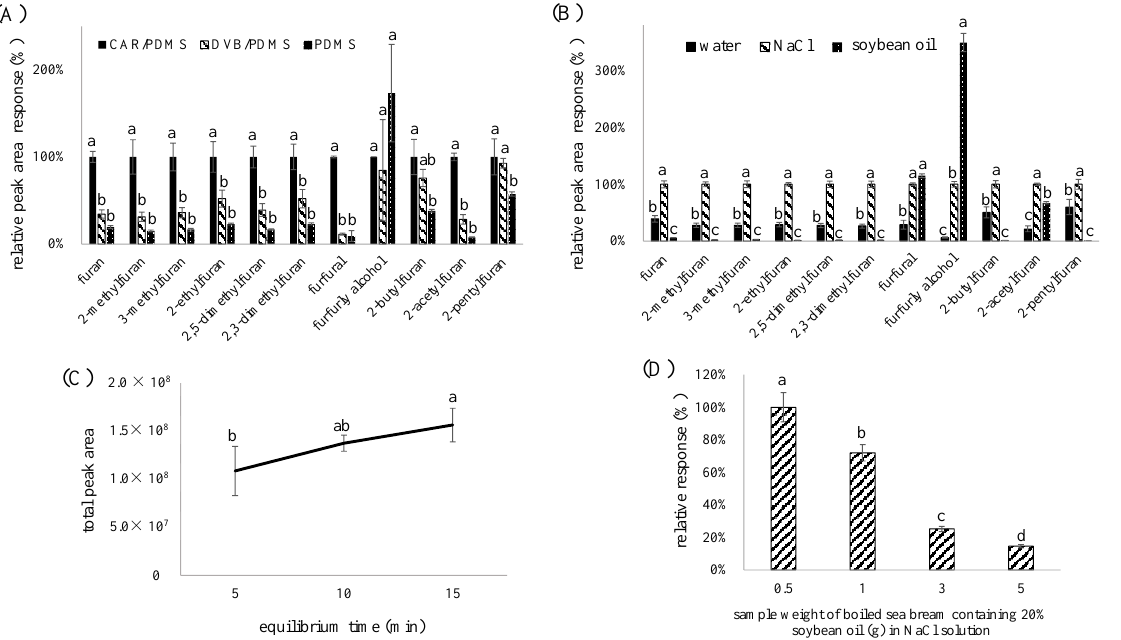
Figure 3. Development of an SPME arrow method for furan and its derivatives extraction. ( A ) Effect of SPME arrow material. ( B ) Effect of diluted solutions. ( C ) Effect of equilibrium time. ( D ) Effect of ratio of oily sea bream weight to saturated NaCl solution. Relative peak area response (%) in y-axis of ( A ), ( B ), and ( D ) were referred to the percentage ratio of the area of each compound extracted by different SPME arrow to the area of each compound extracted by CAR/PDMS. Data with different letters are significant differences at p < 0.05. Saturated NaCl solution was used as diluted solution in Figure 3C.